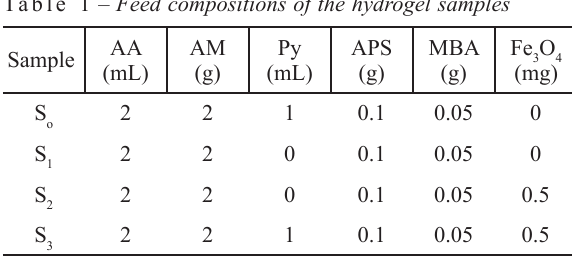
Table 1 – Feed compositions of the hydrogel samples